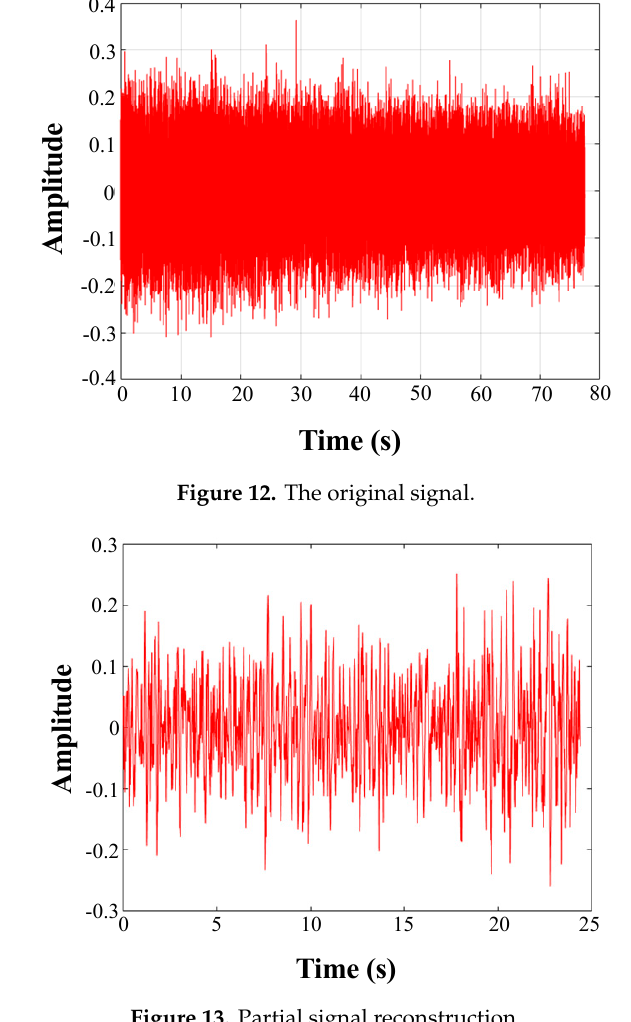
Figure 13. Partial signal reconstruction.